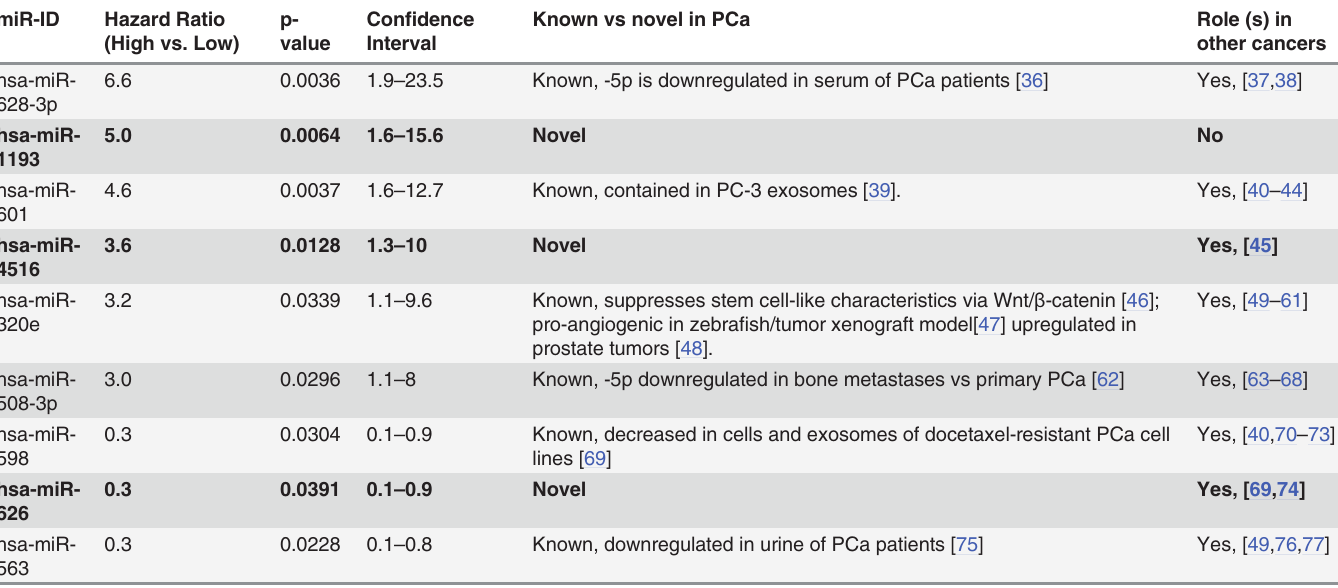
Table 3. miRNAs that correlate with biochemical recurrence after salvage radiation in PCa patients. miR-ID